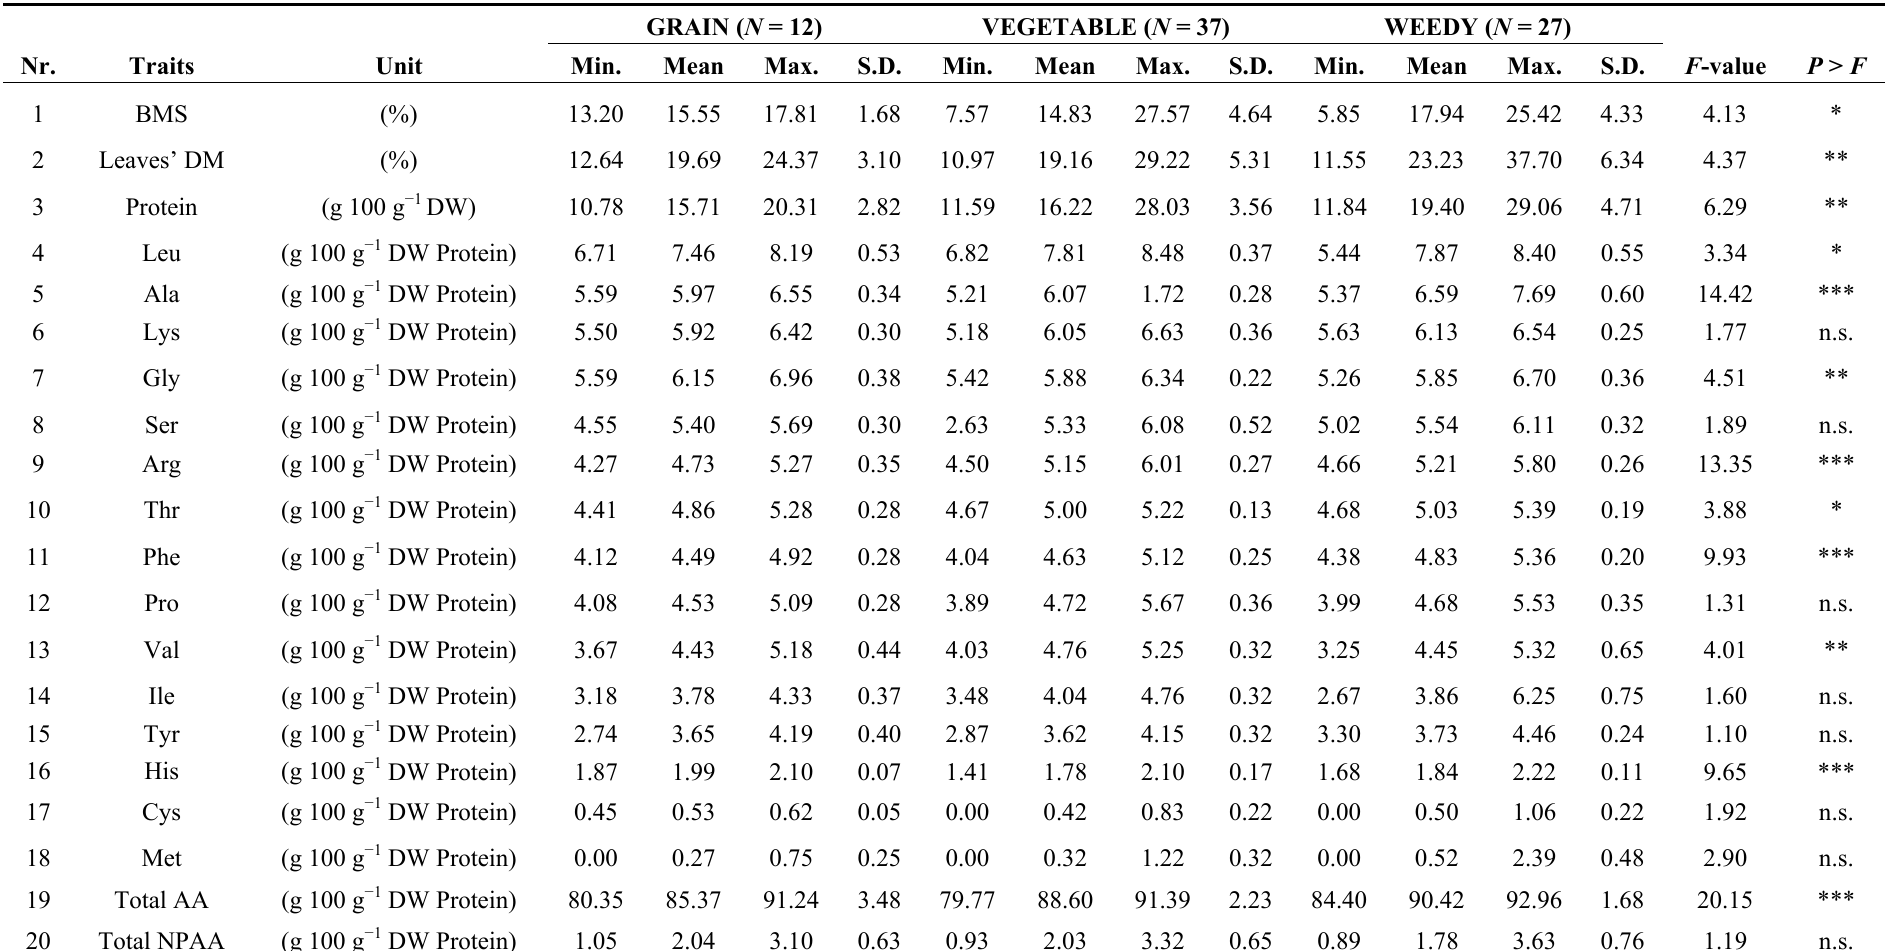
Table 1. Variation of biomass (BMS, %), leaves’ dry matter (in %), protein (g 100 g − 1 DW) and amino acids of amaranths (g 100 g − 1 DW protein) of the grain, vegetable and weedy types of